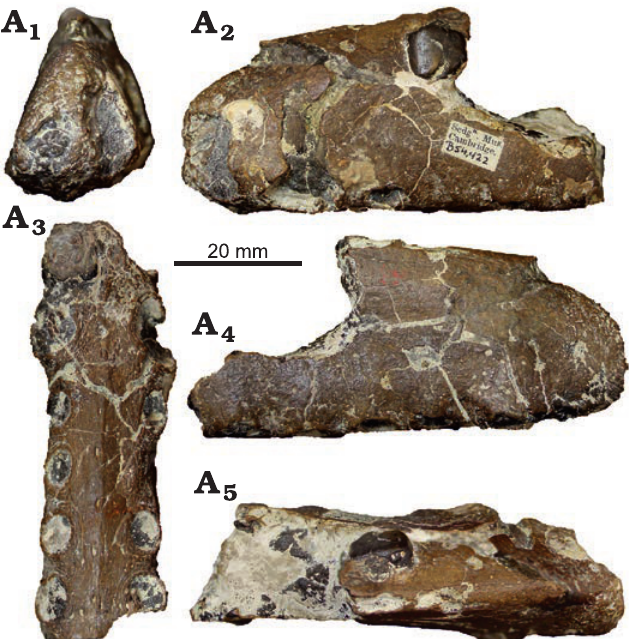
Fig. 6. Anhanguerid pterosaur Aerodraco sedgwickii gen. et comb. nov., CAMSM B54422, Cambridge, Cambridgeshire, England, Albian. In ante­ rior (A 1 ), left lateral (A 2 ), palatal (A 3 ), right lateral (A 4 ), and dorsal (A 5 ) views. Photographs by